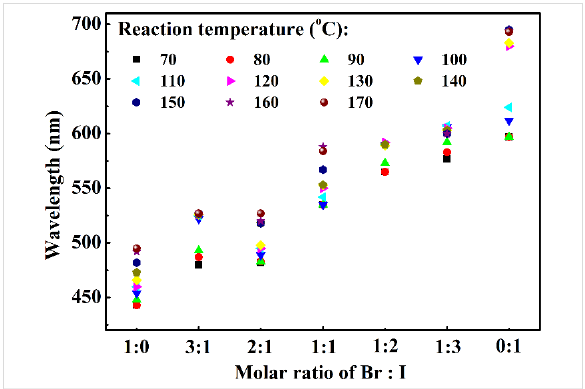
Figure 6: Effect of the Br:I precursor ratio on the peak photolumines- cence wavelength of the quantum dots prepared at different process